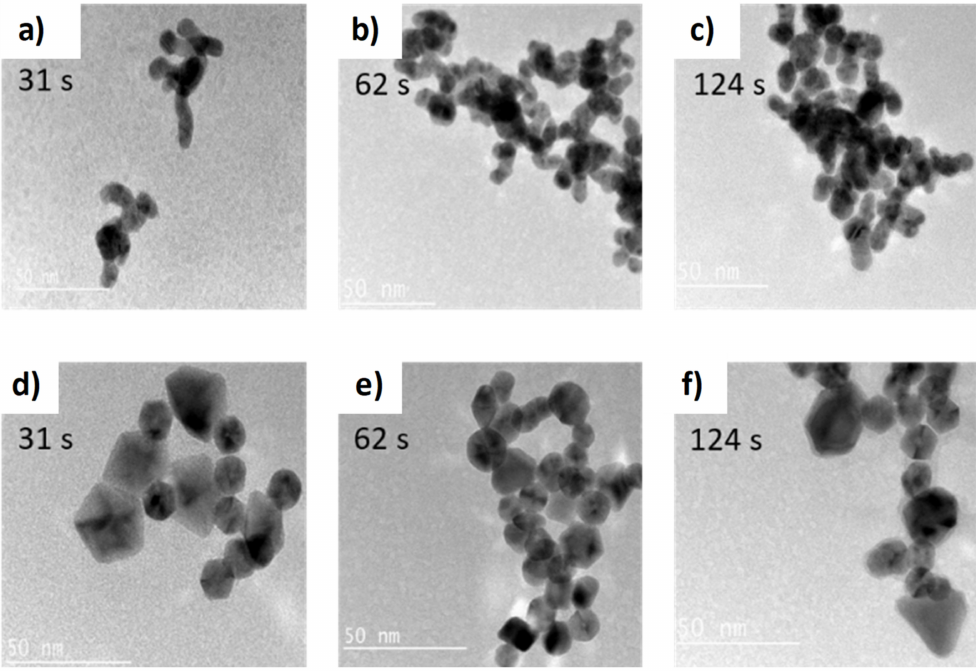
Figure 3. TEM pictures of Pd NPs prepared by the supercritical fluidic approach from Pd(acac) 2 . Influence of reaction time. ( a – c ) in the absence of formic acid, ( d – f ) in the presence of formic acid.